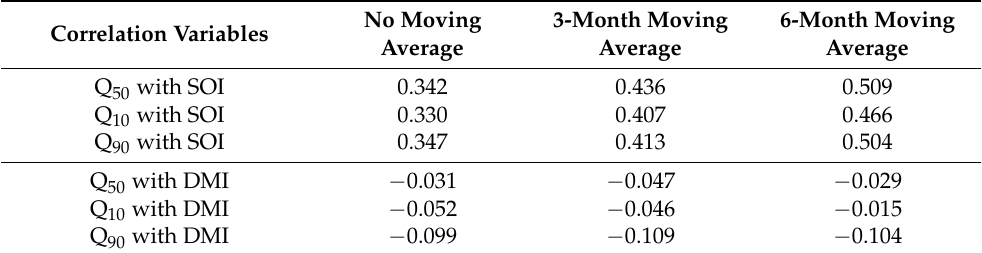
Table 1. The coefficients of the correlation between the observed flow regime indices and climate indices (SOI and DMI) in the monthly